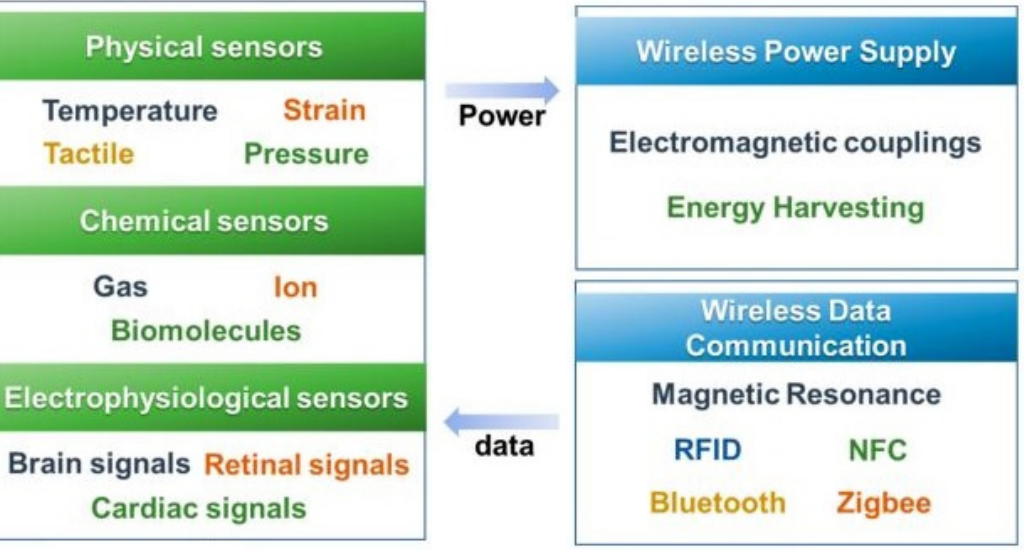
Figure 10. Representation of the components of the wireless protocols used for wearable healthcare systems [161].